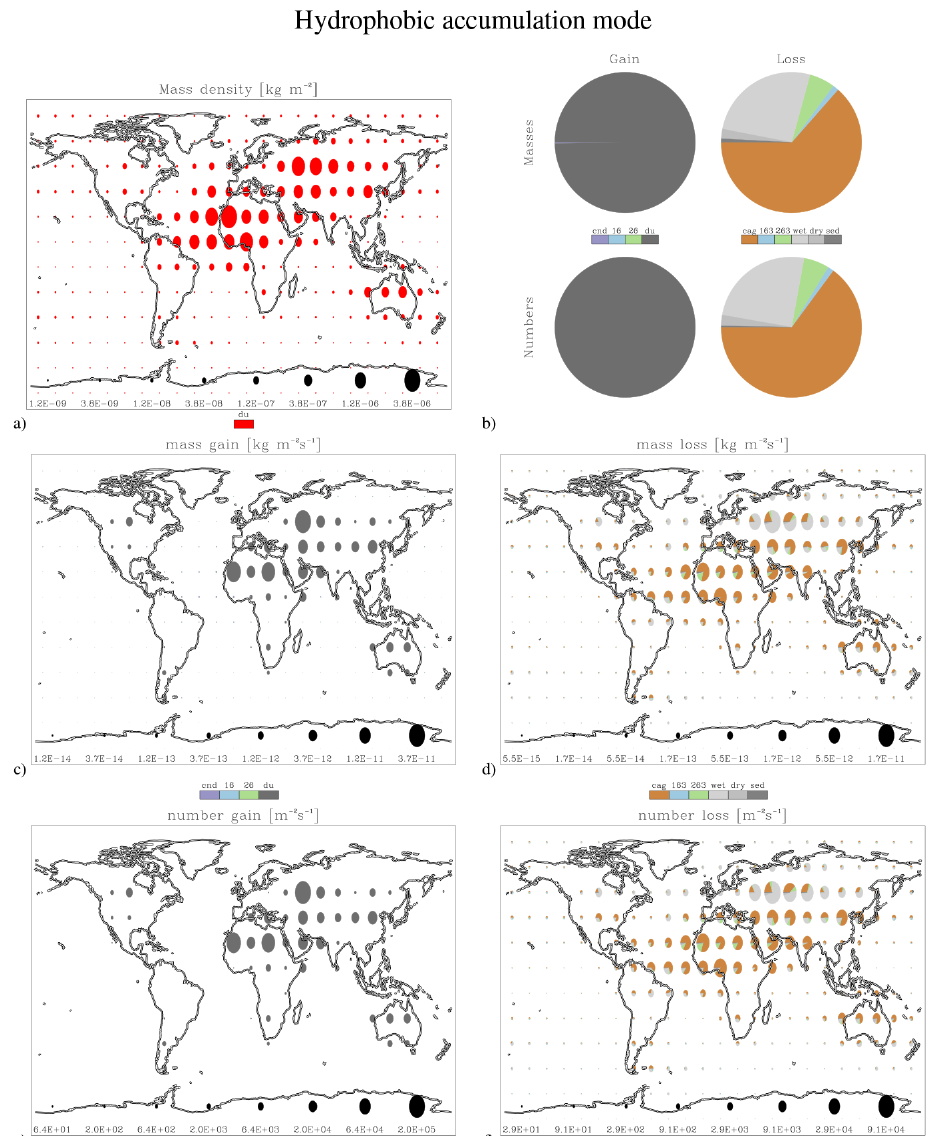
Figure 14. Global distribution of annual burdens (a) and tendencies ( b, c, d, e and f ) of the hydrophobic accumulation mode. The colors indicate either species (defined in Table 3) or processes (defined in Table 2). The pie chart shows fractional contributions, while the radius of the pie indicates total column burden or total column tendency (logarithmic scale as shown in black at the bottom of panels a, c, d, e and f ). Panel b shows a global average of the